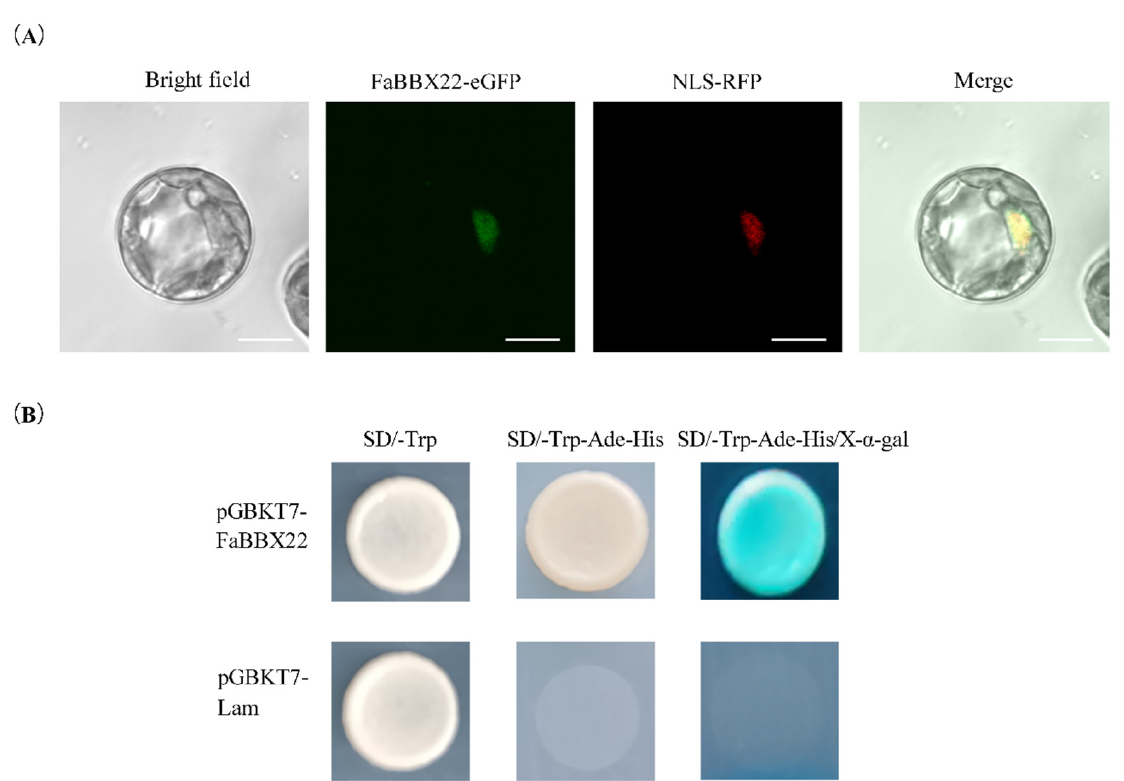
Figure 3. Transcription factor characteristics analysis of FaBBX22. ( A ) Subcellular localization of the FaBBX22 protein. Strawberry protoplasts were transformed with the fusion construct (FaBBX22-eGFP) and a nuclear marker NLS-RFP (NLS, nuclear localization sequence). Bars, 10 μ m; ( B ) Transcriptional activity analysis of FaBBX22 in yeast cell. The yeast cells transformed with pGBKT7-Lam vector were used as a negative control.